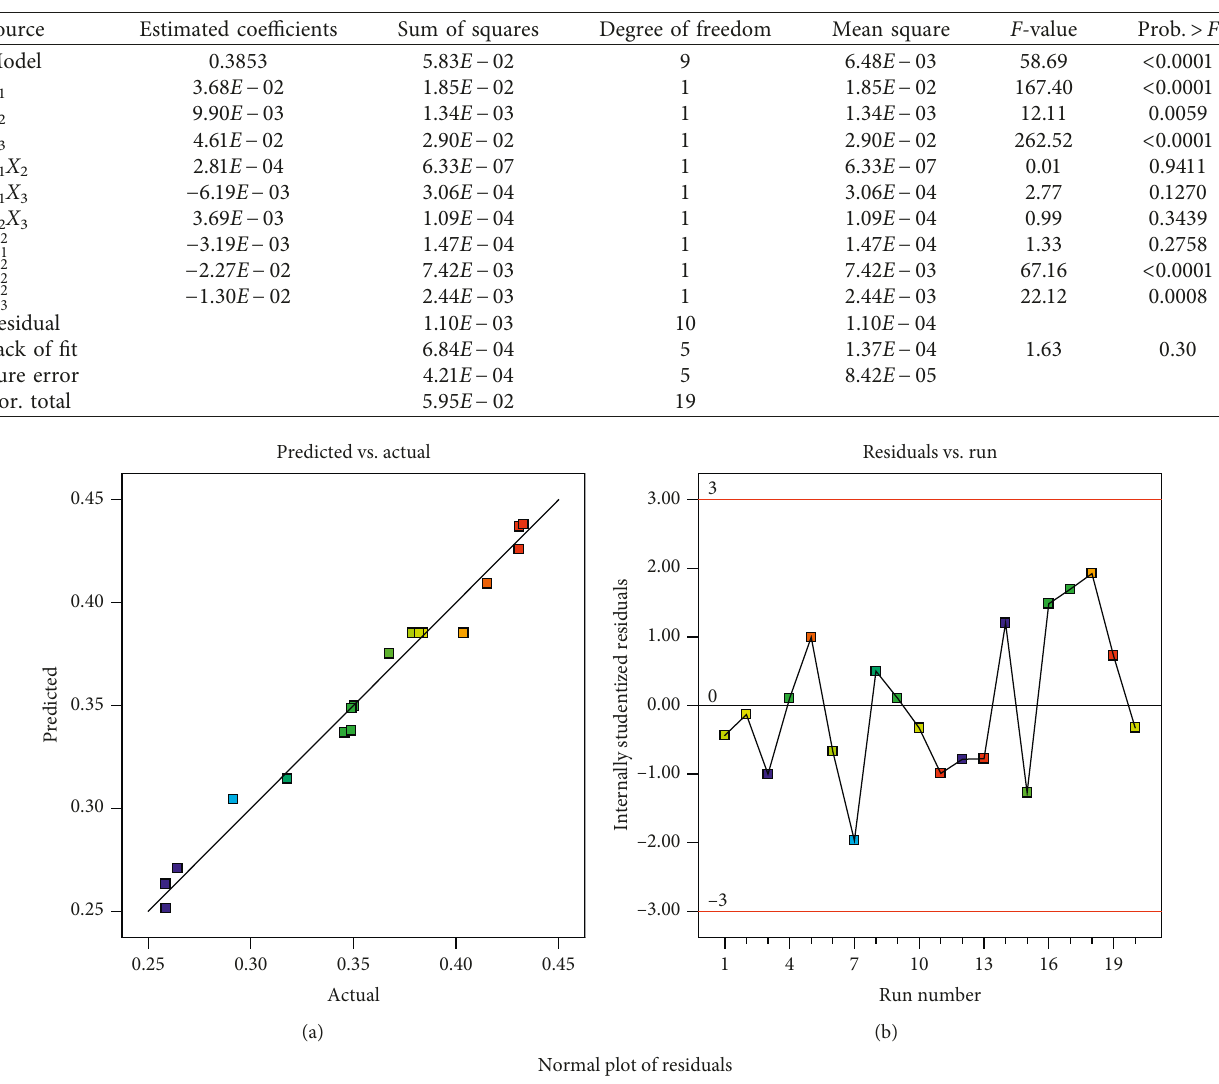
Table 5: Analysis of variance (ANOVA) for the response surface quadratic model.